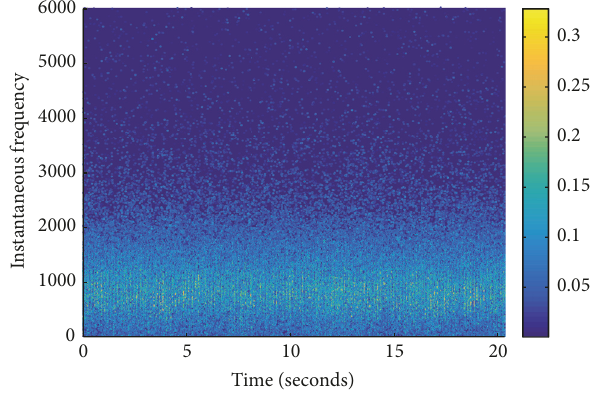
Figure 6: HHT image of baseline raw